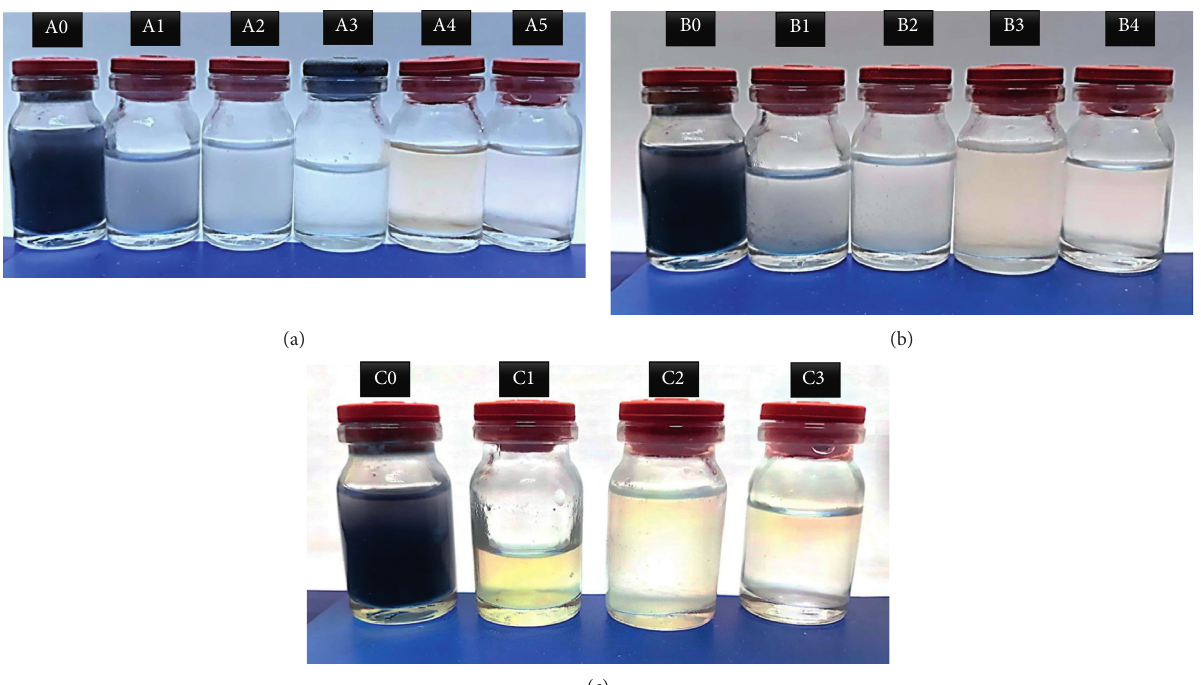
Figure 9: Visual appearance of the raw effluent and the adsorbates obtained according to the different